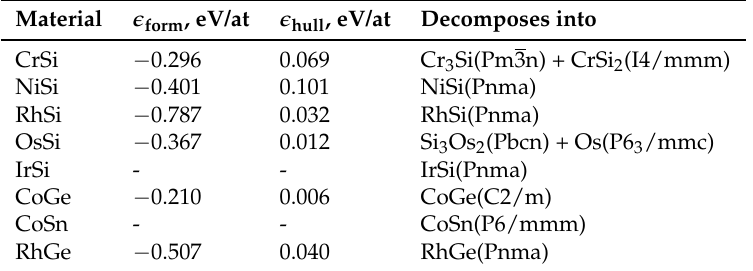
Table 1. Formation ( (cid:101) form ) and decomposition ( (cid:101) hull ) energies following density functional theory (DFT) calculations [65].